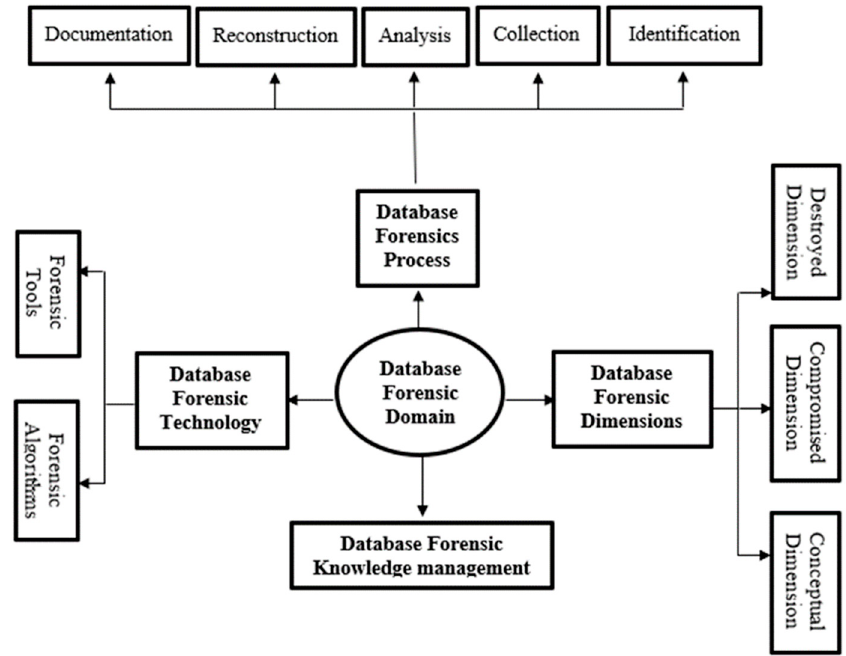
Figure 1. Database forensics